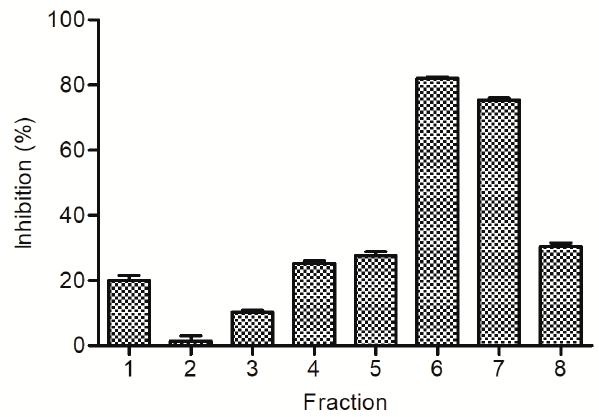
Figure 1. Xanthine oxidase inhibitory activities of the fractions (50 ug/mL) separated from the ethyl acetate-soluble part by RP-18 reversed-phase silica gel open column chromatography. Data represent mean ± S.D. of triplicated experiments.